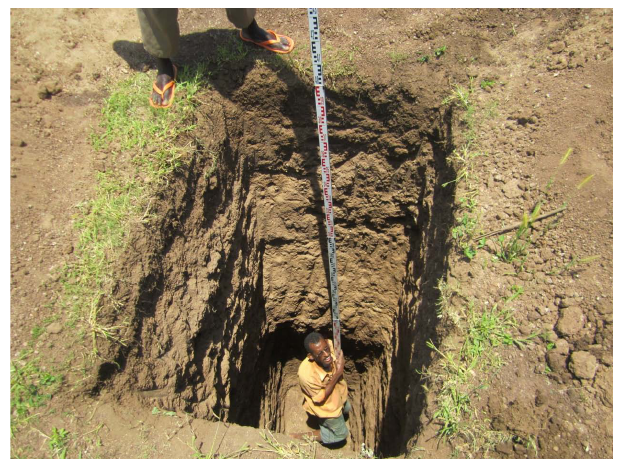
Figure 13. Trench excavation inside Roseires Fig. 13. Trench excavation inside Roseires Reservoir.